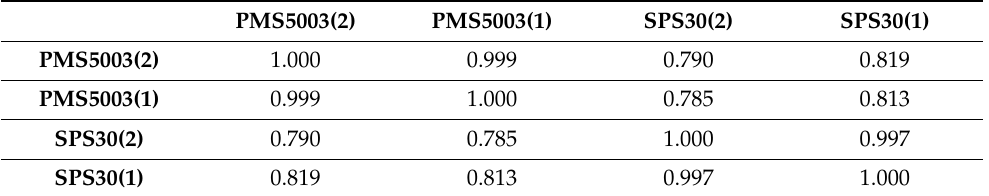
Table 3. Coefficient of correlations related to the sensors involved in the experiment.